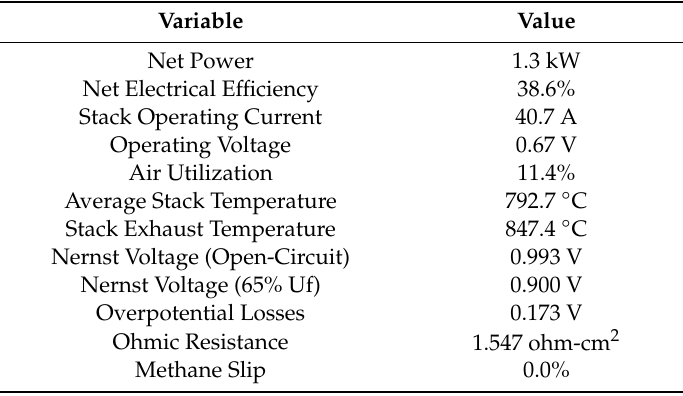
Table 3. Estimated SOFC performance results.